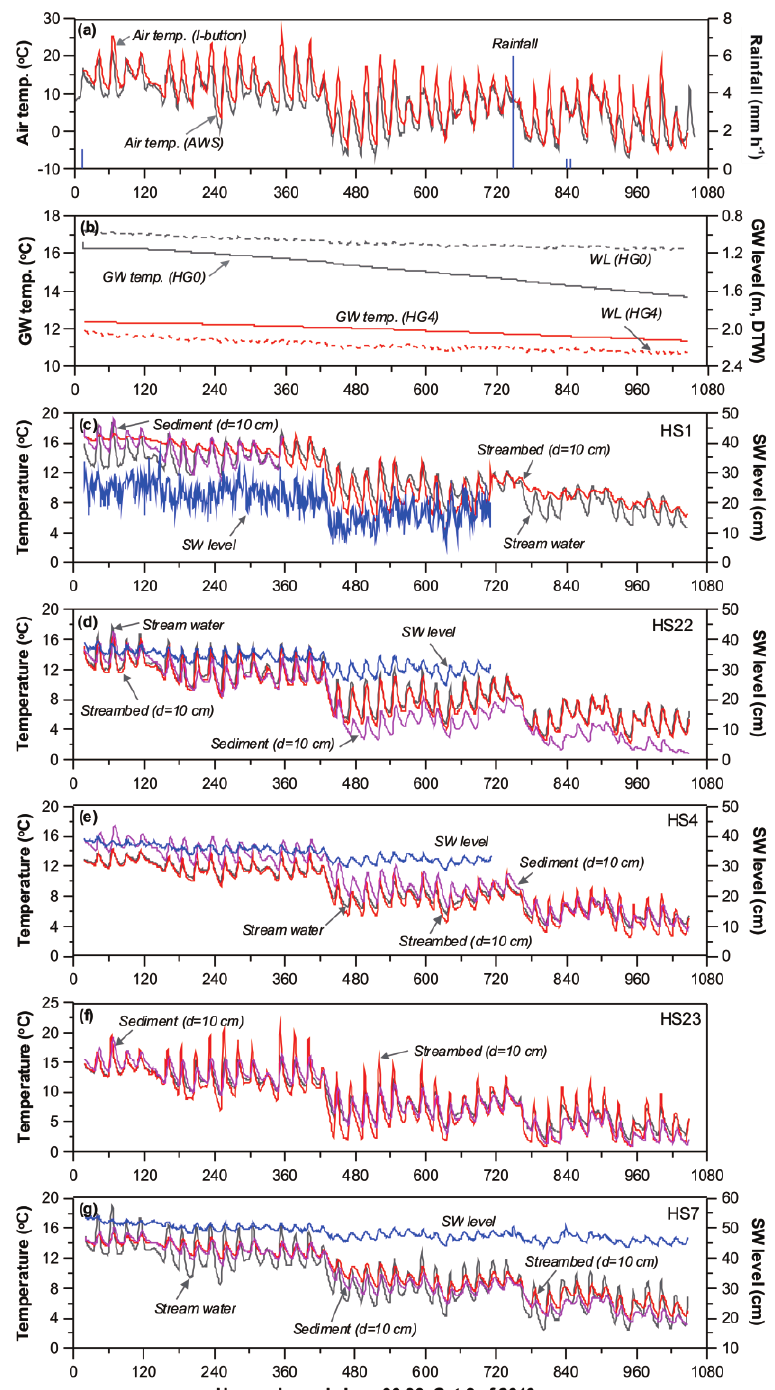
Figure 5. Time series data for measurements of air temperature at ( a ) the AWS and HG0; groundwater level and temperature at ( b ) HG0 and HG4; stream water level, water temperature, streambed temperature, and adjacent sediment temperature at ( c ) HS1; ( d ) HS22; ( e ) HS4; ( f ) HS23; and ( g ) HS7. (GW = groundwater, WL = water level, SW = stream